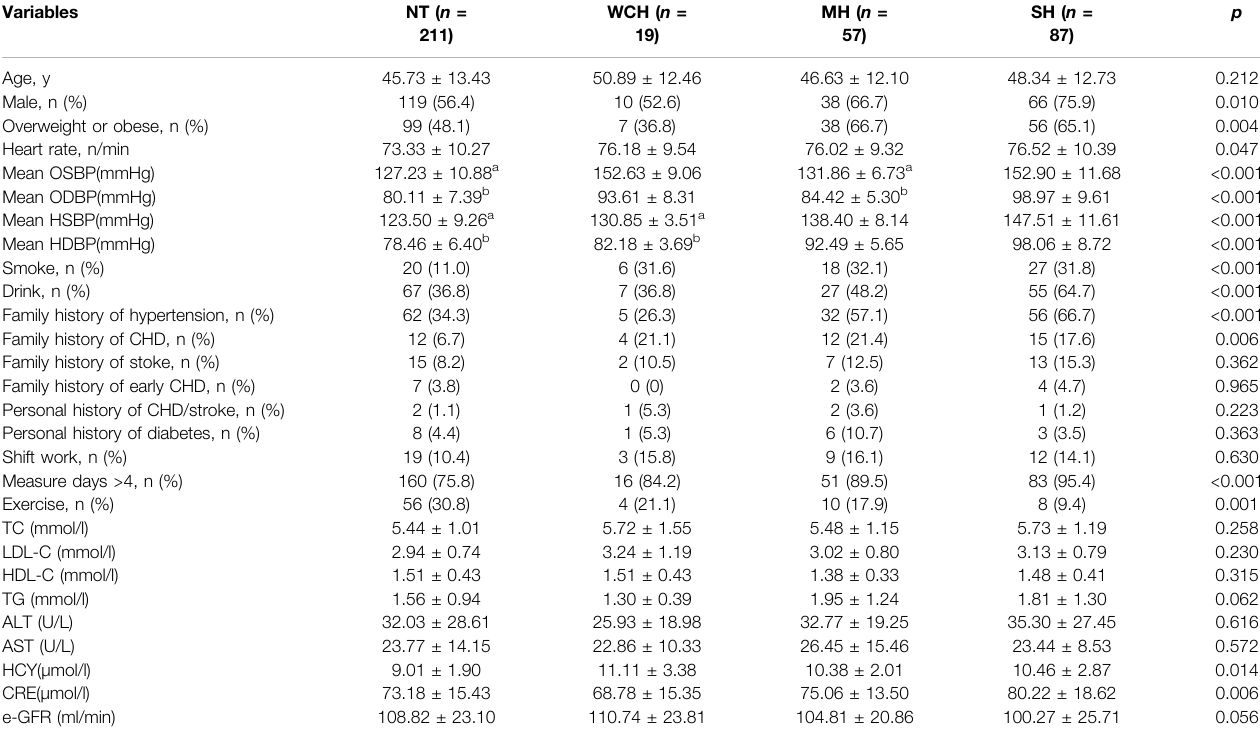
TABLE 1 | Comparison of baseline clinical data under different blood pressure types.